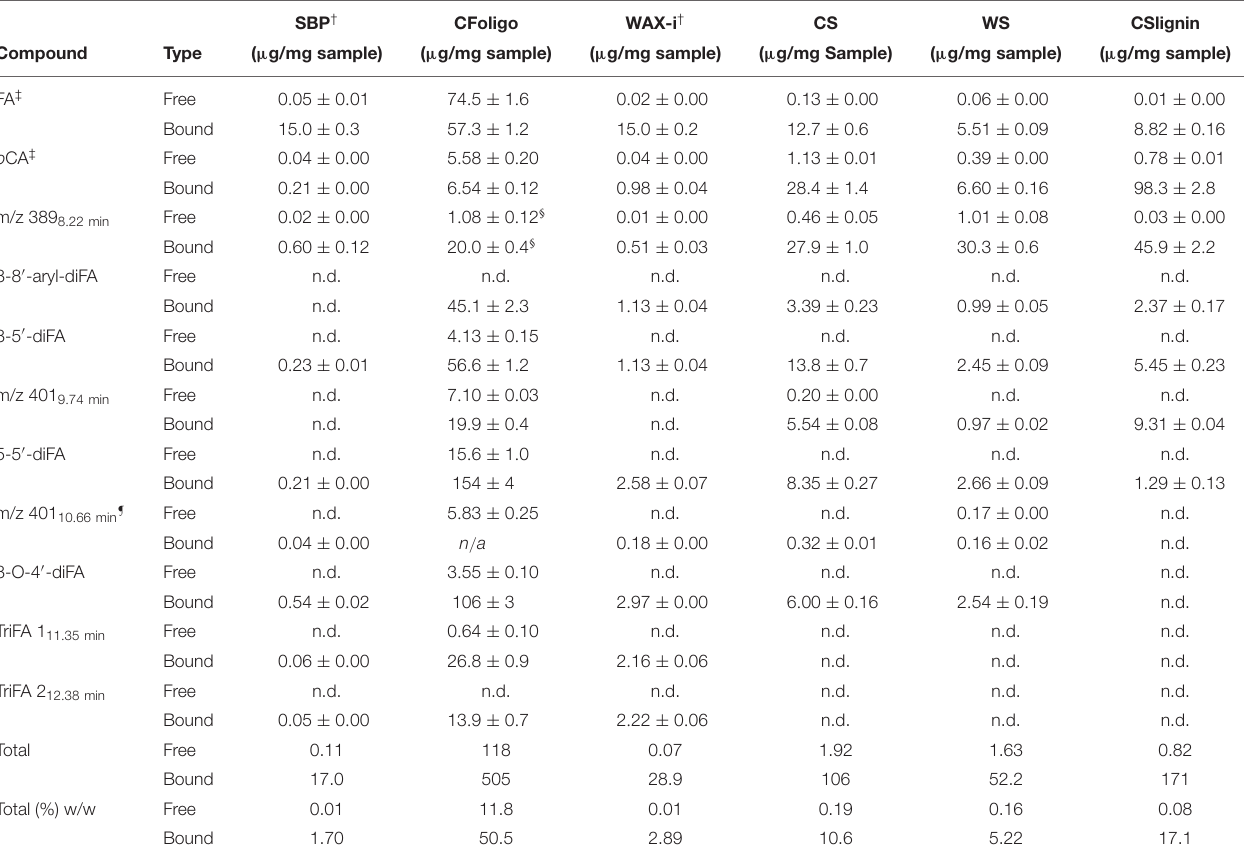
TABLE 3 | Determined (free and bound) hydroxycinnamic acids in PCW-derived and natural substrates. SBP † CFoligo WAX-i †